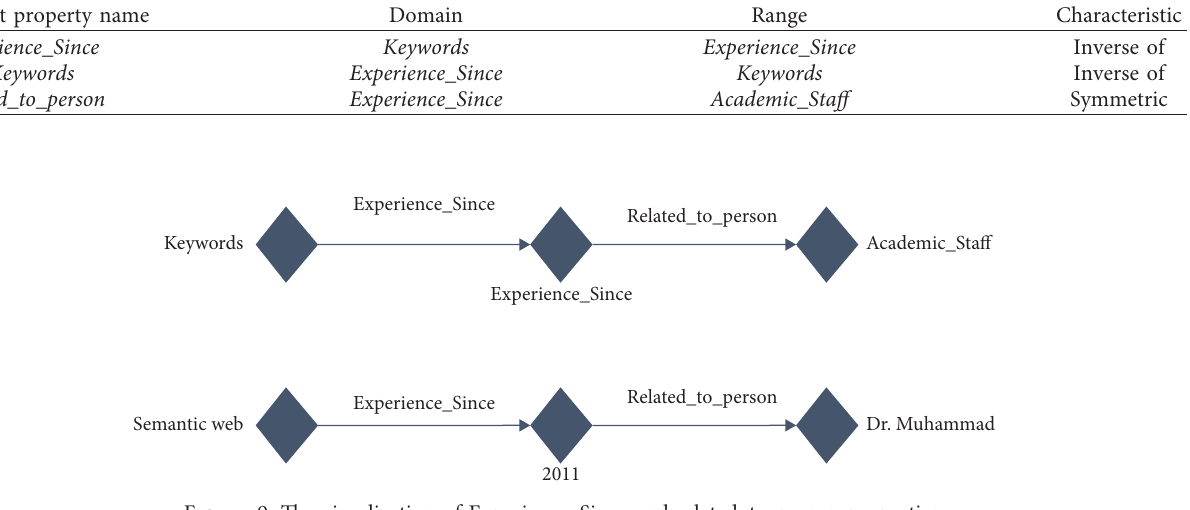
Figure 9: The visualization of Experience_Since and related_to_person properties. Table 9: The research interests’ example after